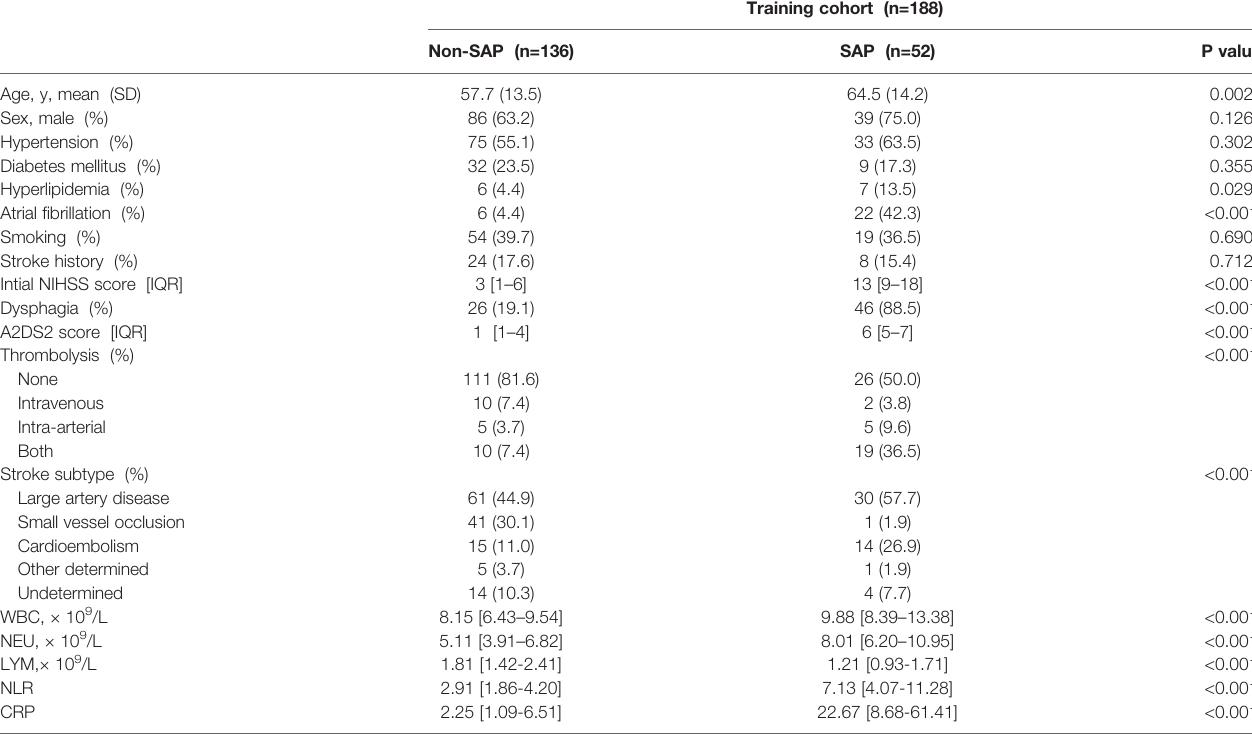
TABLE 1 | Baseline characteristics of patients with SAP and Non-SAP with acute ischemic